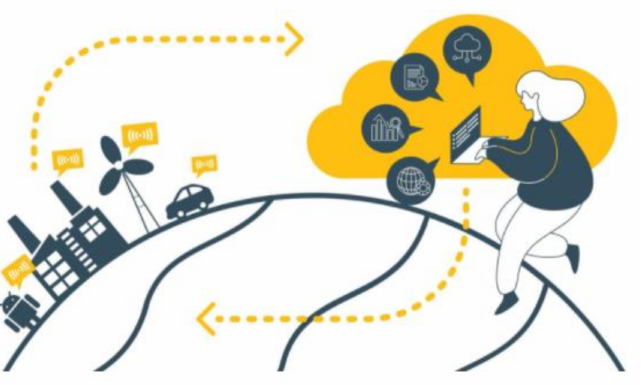
Figure 16. The concept of digitalization.